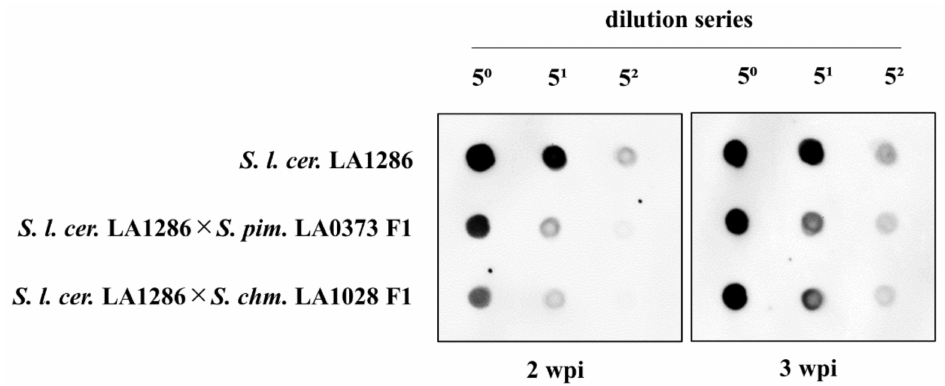
Figure 8. Low PSTVd accumulation in PSTVd-tolerant F1 wild tomatoes. Accumulation of PSTVd in wild tomato relatives was analyzed by dot-blot hybridization with a PSTVd-specific cRNA probe. At 2 weeks post-inoculation (wpi), accumulation of PSTVd decreased in F1 hybrids, especially in S. l. cerasiforme LA1286 × S. chmielewskii LA1028 F1 plants, compared with S. l. cerasiforme LA1286 plants. Afterward, at 3 wpi, the accumulation in F1 hybrids increased to an indistinguishable level compared with S. l. cerasiforme LA1286 plants at 5 0